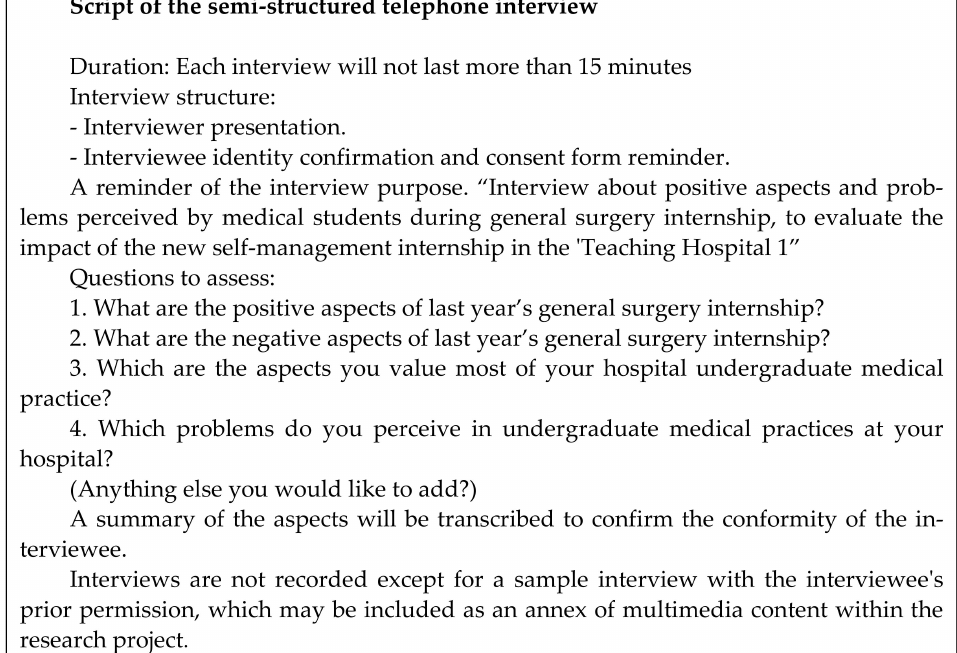
Figure 2. Script of the semi-structured interview used in the qualitative